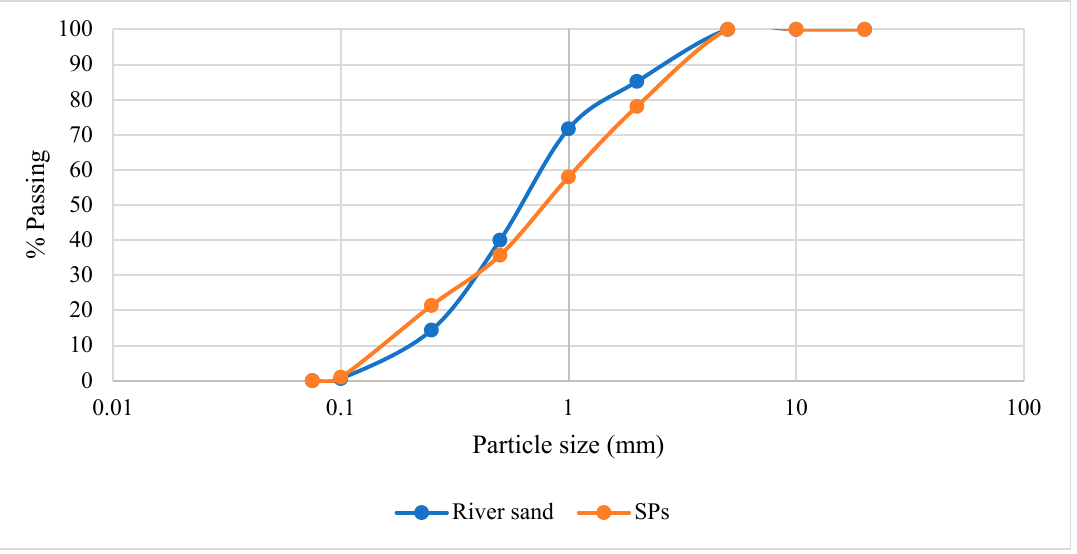
Figure 1. Particle size distribution of aggregates. Table 2. Chemical composition of